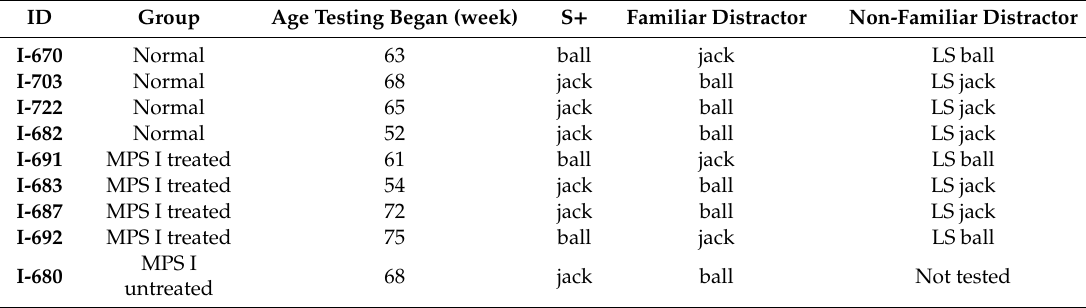
Table 15. Individual data of attention oddity S + . Dog identification, group, age testing began for attention, S + , and familiar, non-familiar distractors (objects) used. LS = large